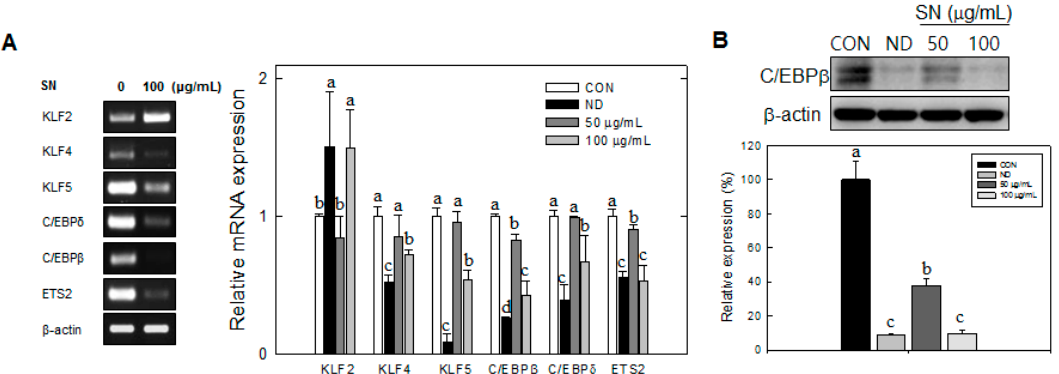
Figure 4. SN regulates mitotic clonal expansion associated genes during the early stages of adipogenesis. ( A ) Mitotic clonal expansion associated genes were assessed by semi-quantitative RT-PCR or qRT-PCR. The levels of gene expression were quantified using the ImageJ software; ( B ) C/EBP β was assessed by Western blot. The level of protein expression was quantified using the ImageJ software. CON: control, SN: seapolynol, ND: non-differentiated 3T3-L1. Data are presented as means ± SD from three replicate experiments. Means not designated by a common superscript are significantly different ( p < 0.05).